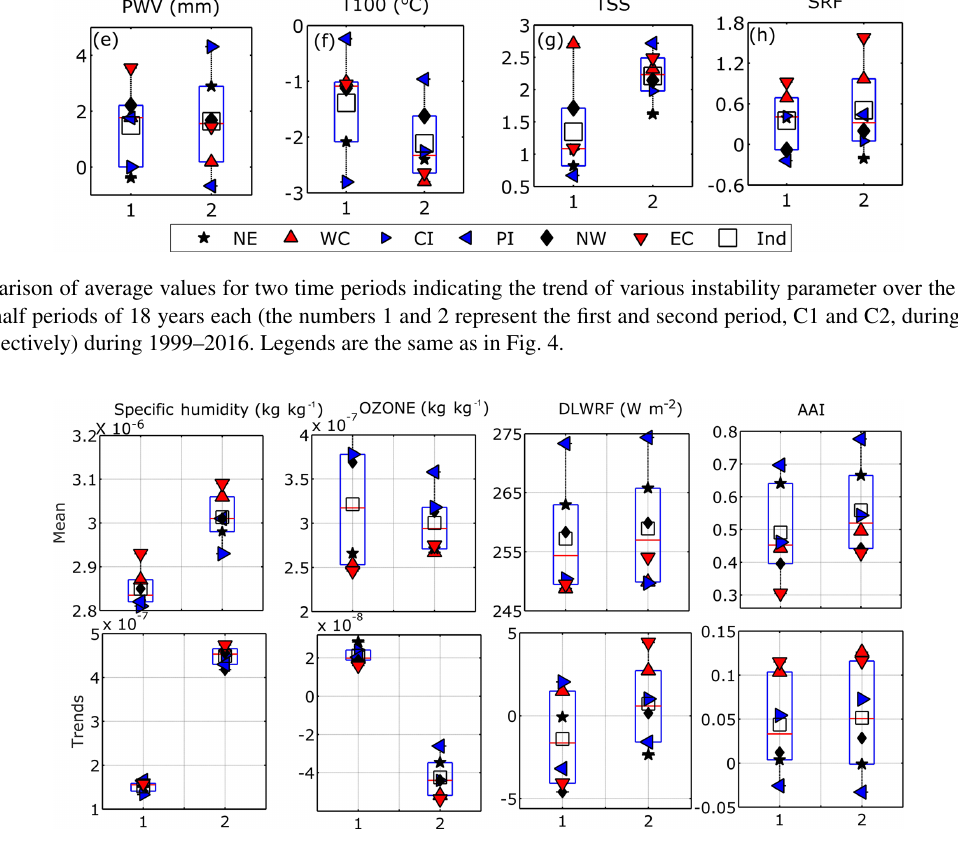
Figure 9. Average values and climatological trends of specific humidity, ozone mixing ratio at 100hPa and downward longwave radiation flux (DLWRF) with Absorptive Aerosol Index (AAI) over the six subdivisions of India over two half periods of 18 years each (1980–1997 and 1999–2016). Legends are the same as in Fig.